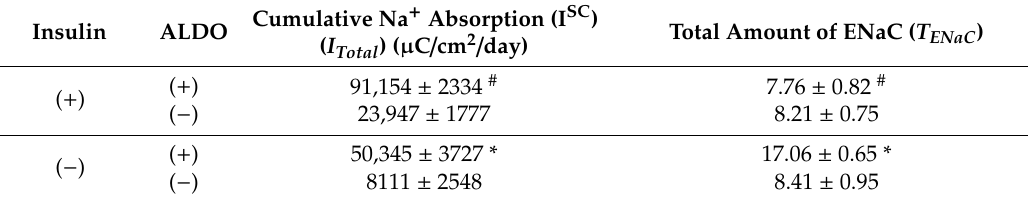
Table 3. The cumulative Na + absorption (I SC ) ( I Total ) ( µ C / cm 2 / day) and the total amount of ENaC ( T ENaC ) under the insulin-stimulated and -unstimulated conditions with and without 1 µ M aldosterone treatment for 20